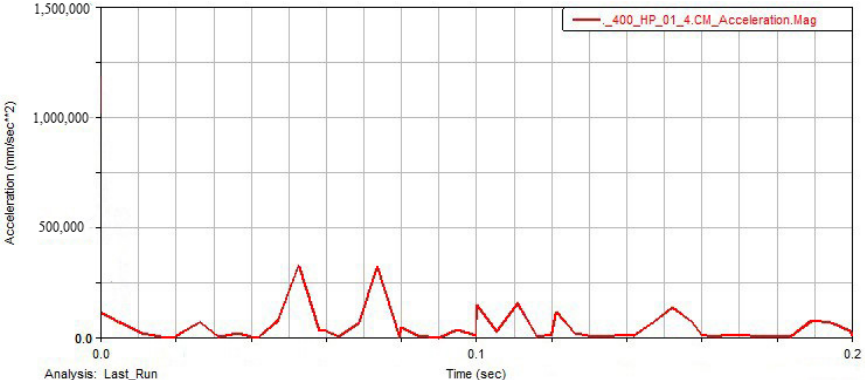
Figure 12. Comparison of slider acceleration after stator optimization.